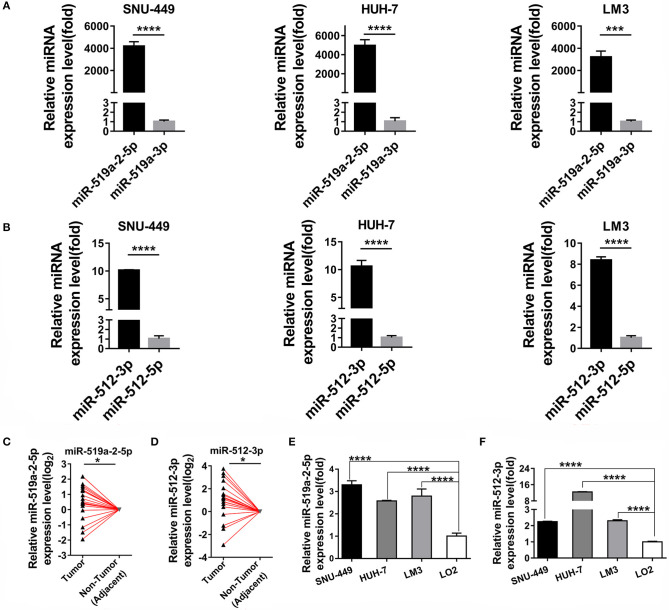
Two miRNA candidates expression levels between hepatocellular carcinoma (HCC) and adjacent non-tumor tissues. (A,B) The expression levels of miR-519a-2-5p (A) and miR-512-3p (B) were upregulated, compared with their complimentary chains (miR-519a-3p and miR-512-3p) from three HCC cell lines. The statistics analysis was performed with the Mann–Whitney test. (C,D) The expression levels of miR-519a-2-5p (C) and miR-512-3p (D) were significantly upregulated in 20 paired HCC tissues, compared with that in paired adjacent non-tumor tissues. The expression levels in adjacent non-tumor tissues were normalized and set as 0. The P-values were calculated with the Student's paired t-test. (E,F) The expression levels of miR-519a-2-5p (E) and miR-512-3p (F) in three HCC cell lines the LO2. The statistics analysis was performed with the one-way ANOVA test. “*”, “***” and “****” represented the p-value < 0.05, 0.001 and 0.0001, respectively.